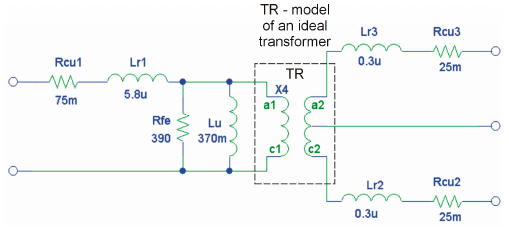
Figure 13. Equivalent circuit of the pulse transformer. Energies 2020 , 13 , 3285